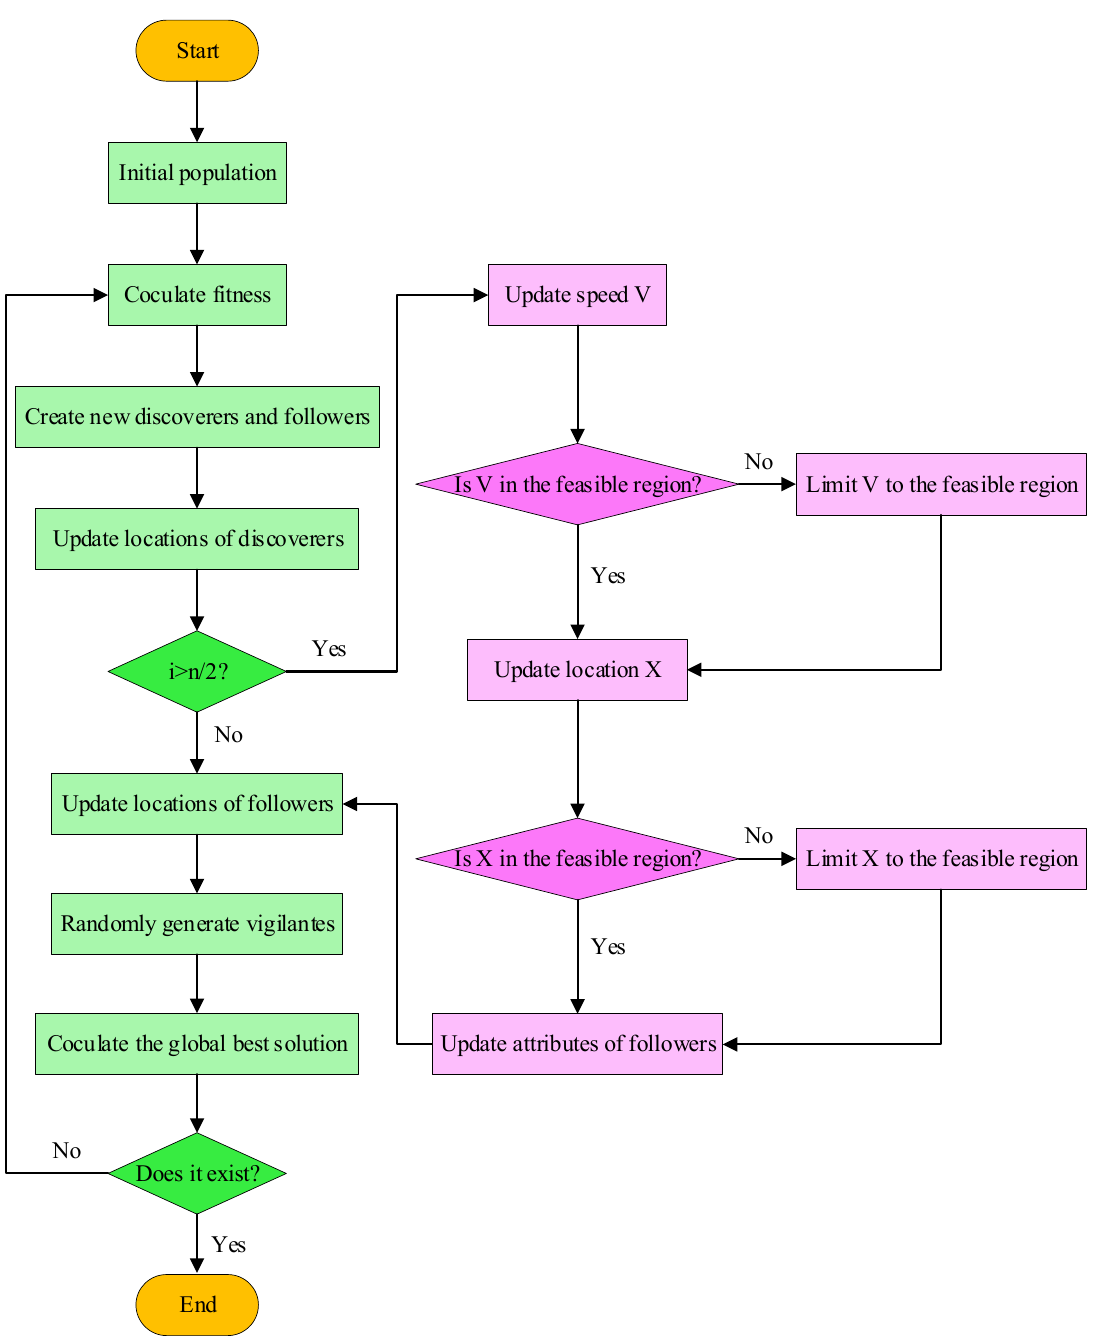
Figure 1. Steps of HSSA. Firstly, the initial population is randomly generated. Secondly, a fitness function is determined to evaluate the fitness of each individual and update the best solution. Thirdly, the population is divided into discoverers and followers based on fitness to update positions of discoverers and followers. If i > n /2, the PSO part is used to calculate the position of followers. Vigilantes are then randomly generated to update their position. Finally, the global best solution is calculated to determine whether the ending condition is met. The above steps are repeated until an individual that meets the ending condition is found. An individual who meets the ending condition is considered the best solution of HSSA.